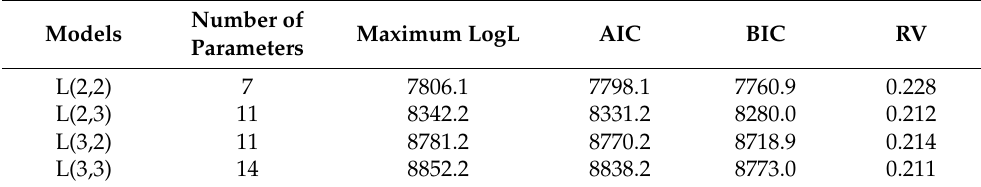
Table 1. Criteria used for comparison of the models.